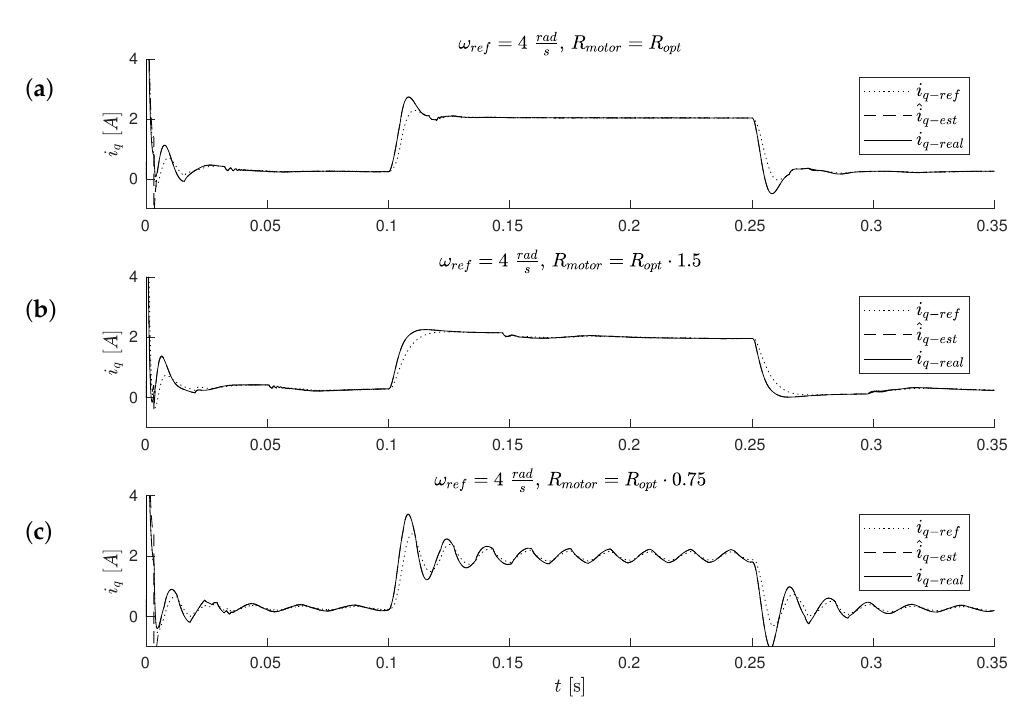
ˆ i q est , and measured i q ref , estimated − − R opt . ·